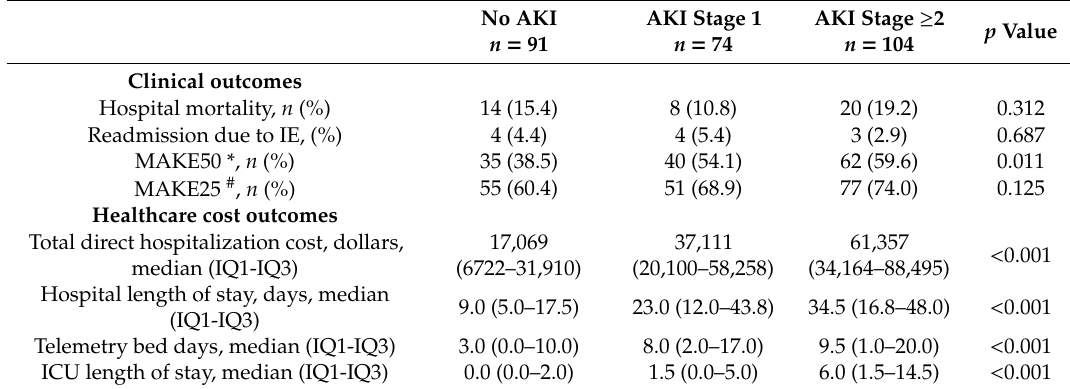
Table 3. Study outcomes in hospitalized patients with infective endocarditis according to acute kidney injury